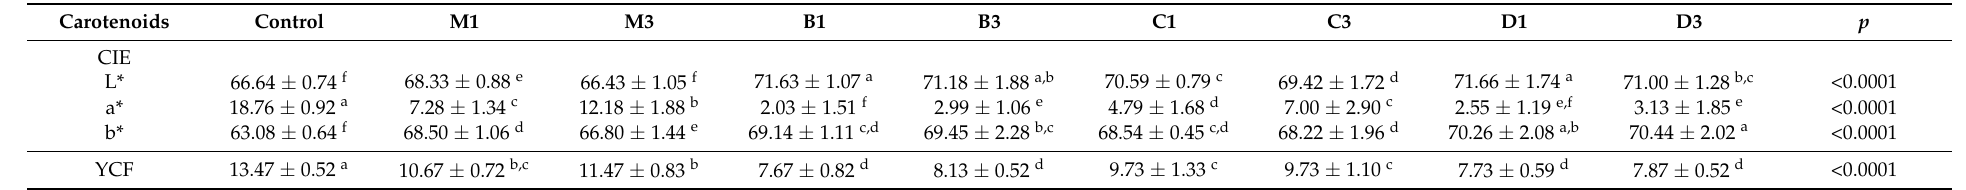
Table 4. Egg yolk color (average ± SD) according to the CIE Lab scale and DSM Yolk Color Fan (YCF) from hens differentiated in pigment supplementation (B1 and B3—1% and 3% basil herb; C1 and C3—1% and 3% calendula flower; D1 and D3—1% and 3% dandelion flower; and M1 and M3—1% and 3% marigold flower). Carotenoids